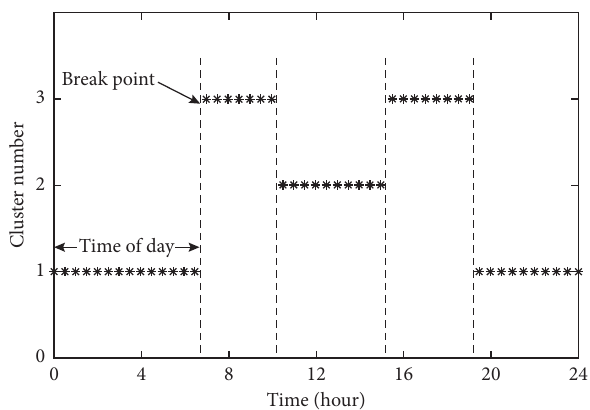
Figure 1: Interval classification and breakpoints of